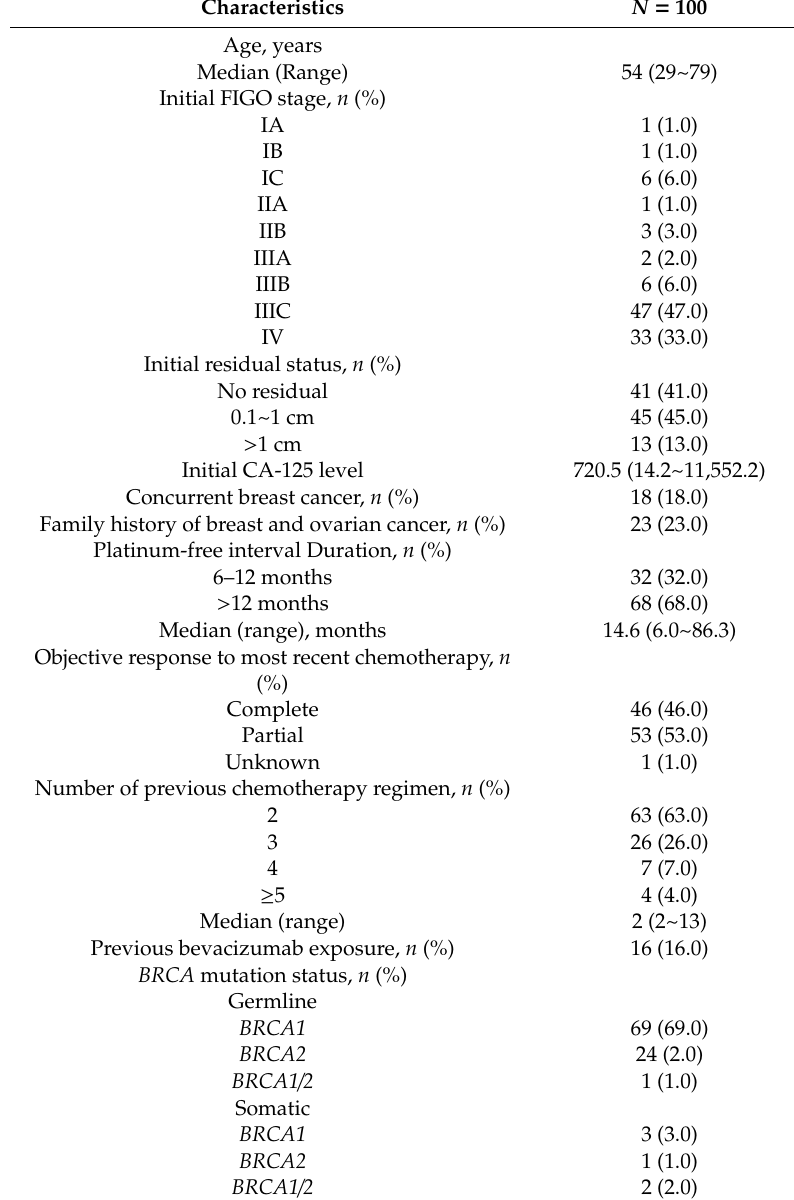
FIGO: International Federation of Gynecology and